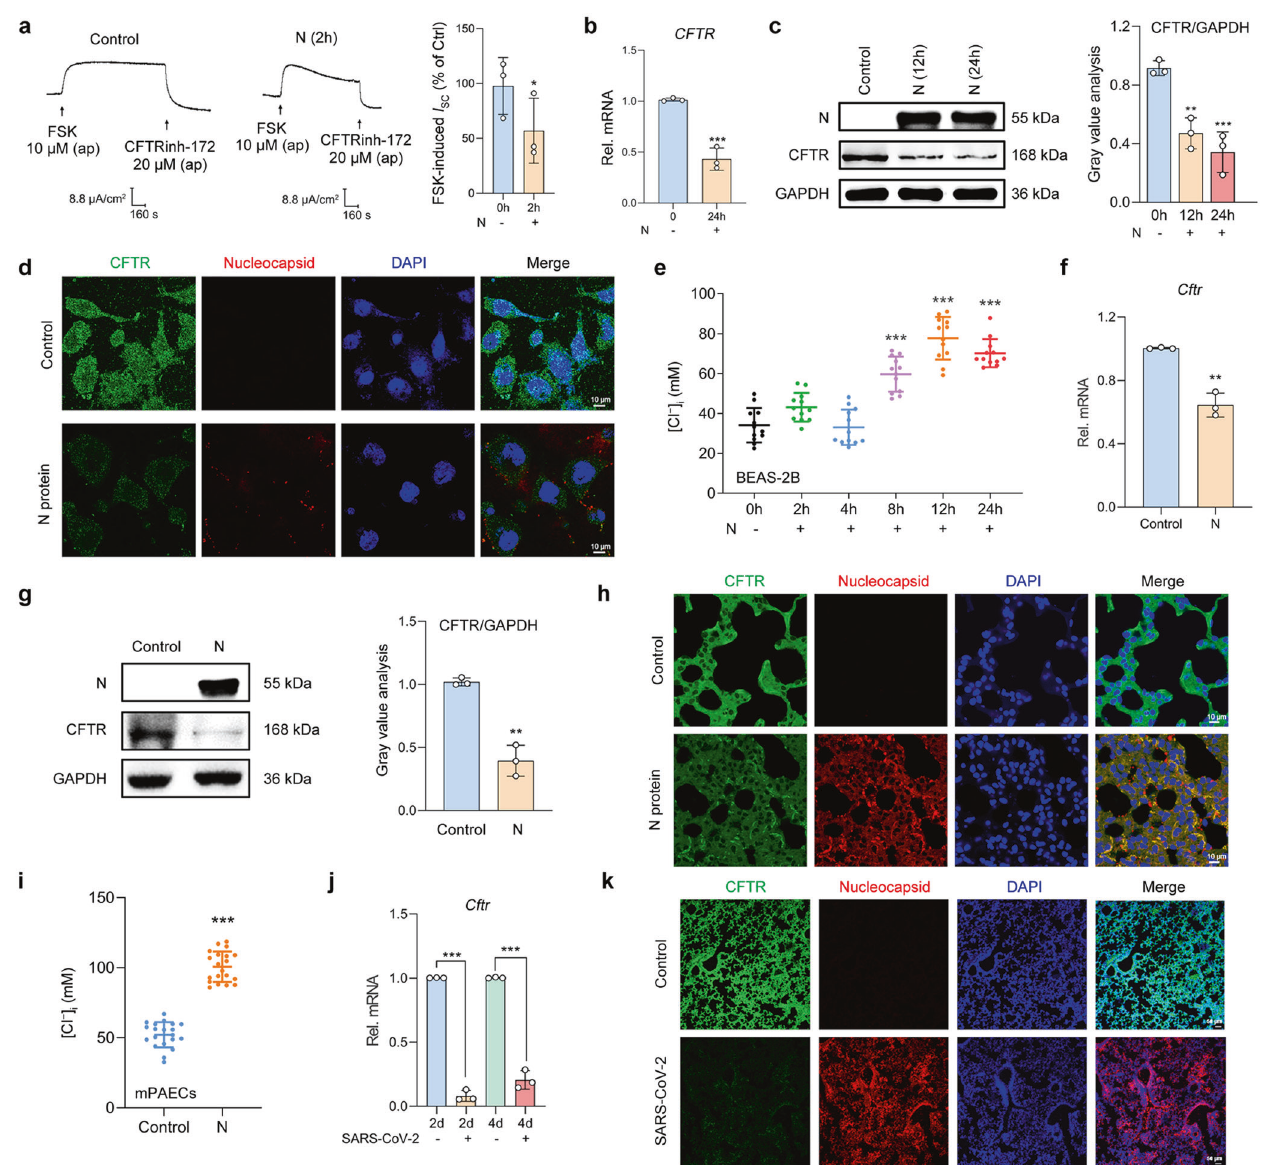
Fig. 2 SARS-CoV-2 N protein triggered the downregulation of CFTR and increased [Cl − ] i in RECs. a Representative traces showing the effect of N protein (50 μ g/ml) on I SC responses induced by forskolin (FSK, 10 μ M) in 16HBE14o- cells, with the statistical analysis ( n = 3). b The mRNA expression levels of CFTR in N protein (50 μ g/ml)-stimulated BEAS-2B cells ( n = 3). c The expression of CFTR after N protein (50 μ g/ml) stimulation in BEAS-2B cells, with the gray value analysis ( n = 3). d Fluorescence labeling of CFTR (green) and N protein (red) in BEAS-2B cells with DAPI-labeled nuclei (blue) after stimulation with N protein (50 μ g/ml) for 24 h. Scale bars, 10 μ m. e The changes in [Cl − ] i of BEAS-2B cells after N protein (50 μ g/ml) stimulation ( n = 12 cells). f The mRNA expression level of Cftr in the lungs of N protein (0.25 mg/kg)-stimulated mice ( n = 3). g The expression of CFTR after N protein (0.25 mg/kg) stimulation in the lungs of mice, with the gray value analysis ( n = 3). h Fluorescence labeling of CFTR (green) and N protein (red) in mouse lung slices with DAPI-labeled nuclei (blue) after N protein (0.25 mg/kg) stimulation. Scale bars, 10 μ m. i The changes in [Cl − ] i of mPAECs from mice after N protein (0.25 mg/kg) stimulation ( n = 20 cells). j The mRNA expression level of Cftr in the lungs of hACE2-transduced mice infected with SARS-CoV-2 (1 × 10 5 PFU) ( n = 3). k Fluorescence labeling of CFTR (green) and N protein (red) in lung slices of hACE2-transduced mice infected with SARS-CoV-2 (1 × 10 5 PFU). Scale bars, 50 μ m. Data were shown as mean ± SD, * P < 0.05, ** P < 0.01, *** P < 0.001 compared with the control group or indicated by